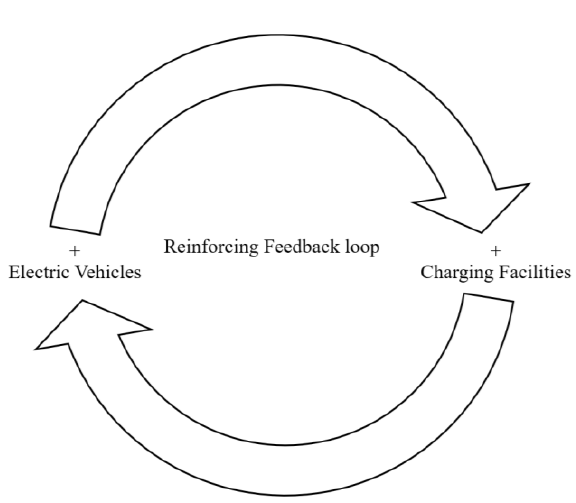
Figure 1. Mutual reinforcing relation between EVs and